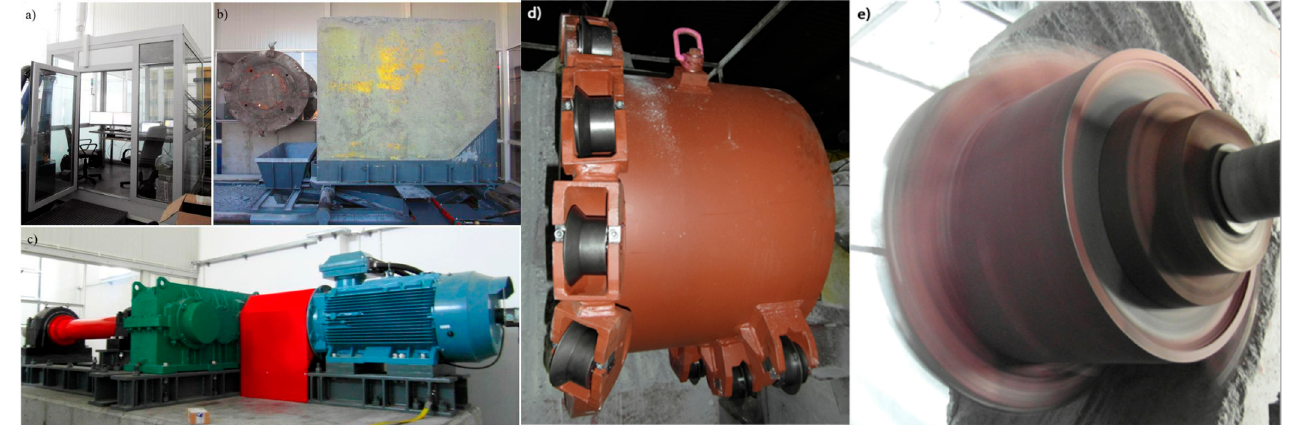
Figure 12. Full-size bench for testing the cutting process: ( a ). measuring cabin, ( b ). the test plate with a sample, ( c ). 250 kW drive system, ( d ). disc cutter head, and ( e ). cutting with a disc cutter head ( a – c) [69], ( d , e ) [31].